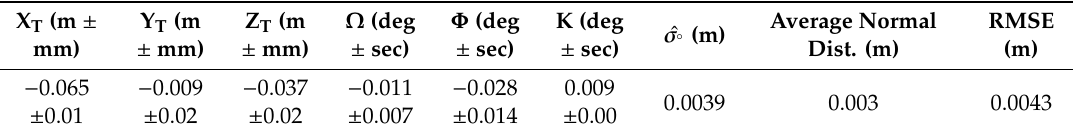
Table 10. Estimated transformation parameters and quality measures (square root of a-posteriori variance factor, average normal distance among point-patch pairs, and RMSE of the normal